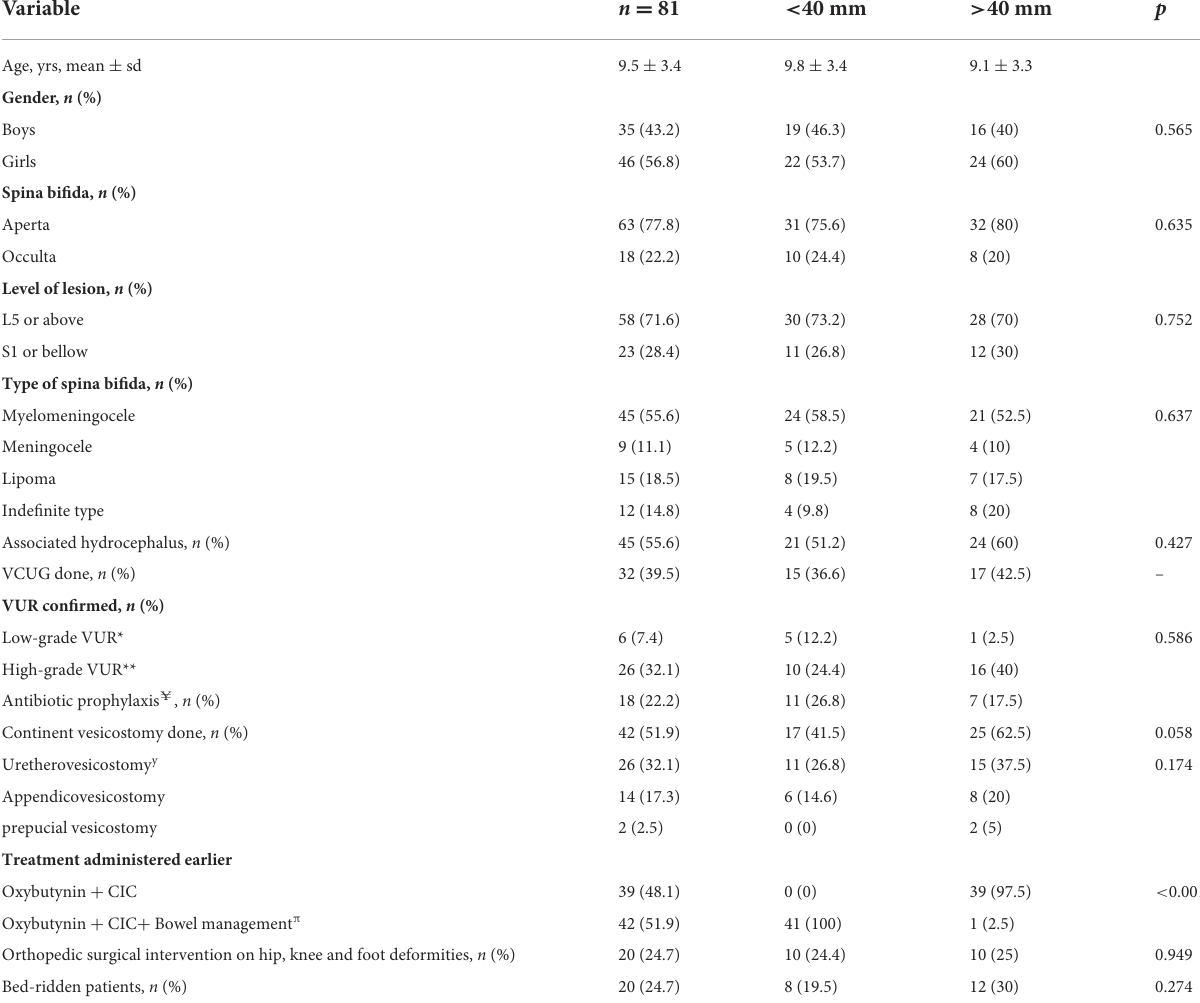
TABLE 1 Baseline demographic and clinical features of study population according to tranversal rectal diameter.